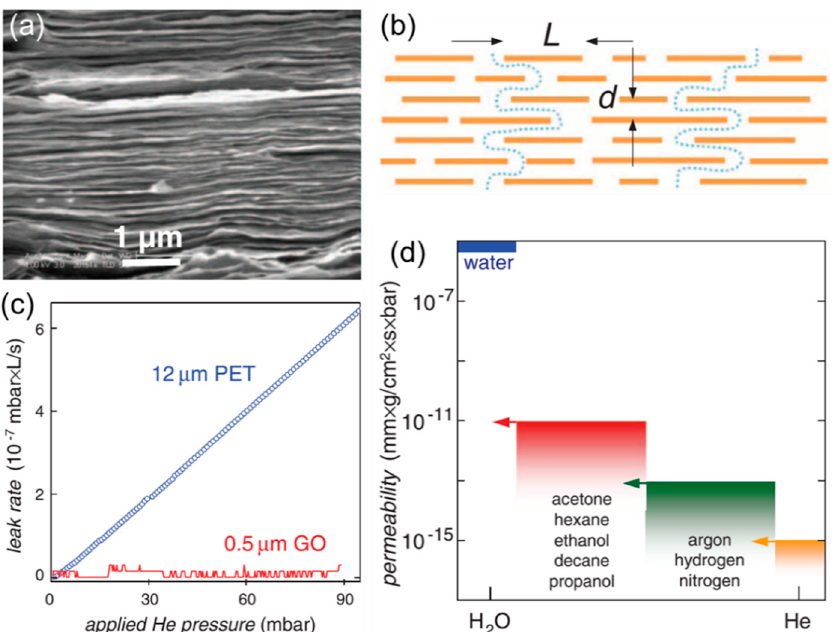
Figure 2. ( a ) Cross-sectional SEM image of a GO film. ( b ) A schematic view of molecular permeation through the GO film. ( c ) He-leak rates in a 0.5-µm GO film and a 12-µm PET film. ( d ) Permeability of water and various small molecules through a GO film. The arrows indicate the upper limit of the permeabilities determined by their experiments [11]. Reprinted with permission from AAAS.